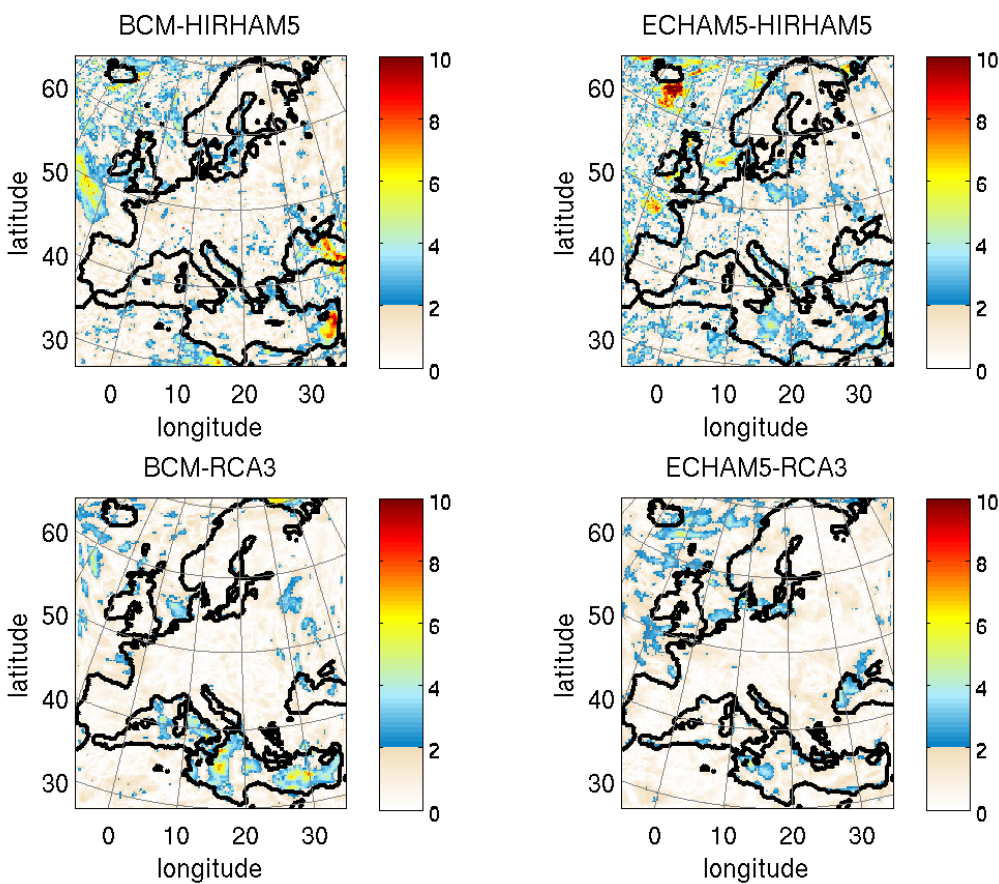
Fig. 2. The magnitude of the change in 50yr return 10m wind speed between the reference 30yr period (1961–1990), and the future 30yr period (2070–2099). The estimates are in in ms − 1 and show the results for the four different downscalings. The beige regions indicate locations where the projected changes in the 50yr return 10m wind speeds of 2ms − 1 or less, while the blue to red regions indicate those locations with 50yr winds between 2 and 10ms − 1